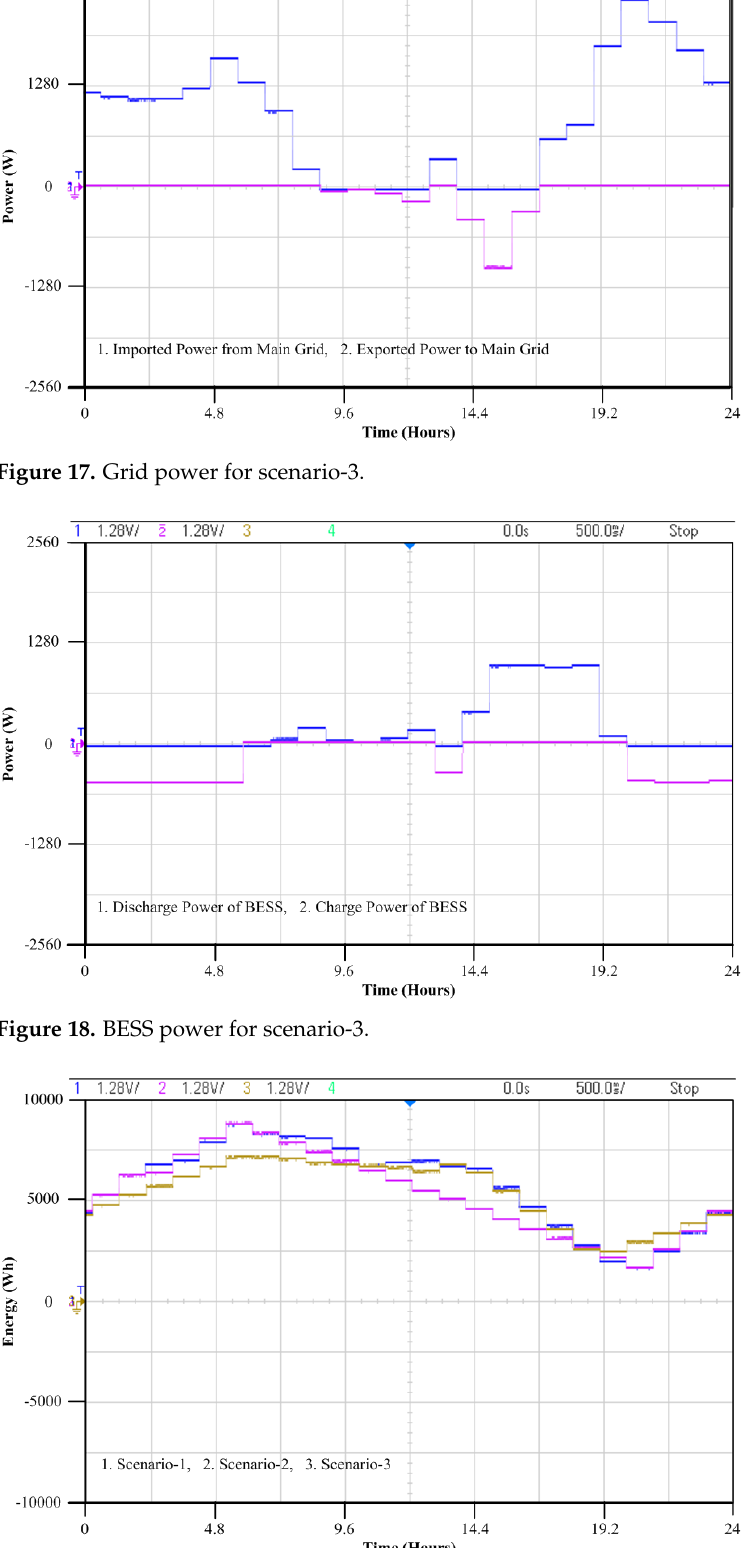
Figure 19. BESS capacity for all